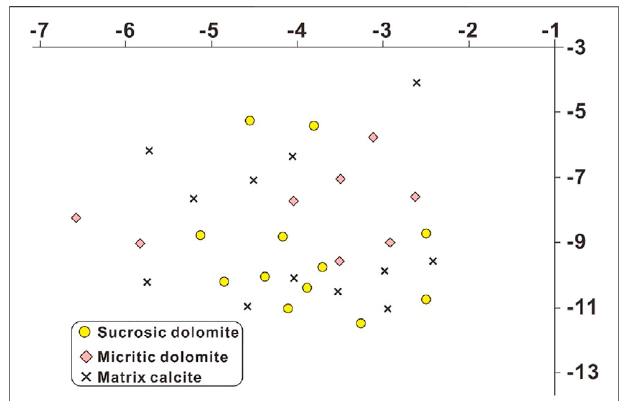
FIGURE 4 | Crossplots showing random correlation between carbon and oxygen